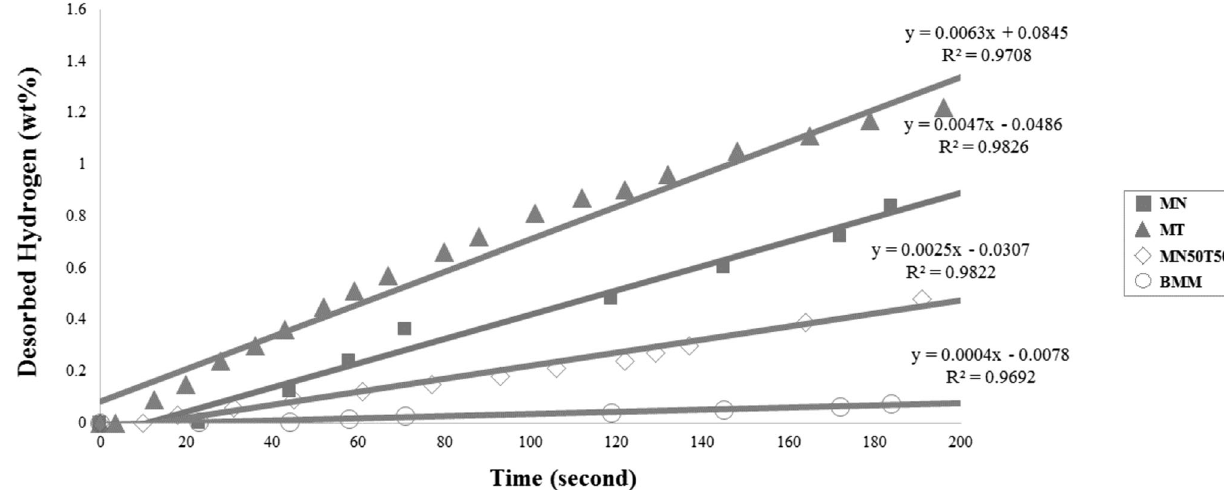
Fig. 6 Desorption results of the samples within the first 200 s Fig. 7 Onset time of hydrogen desorption of the